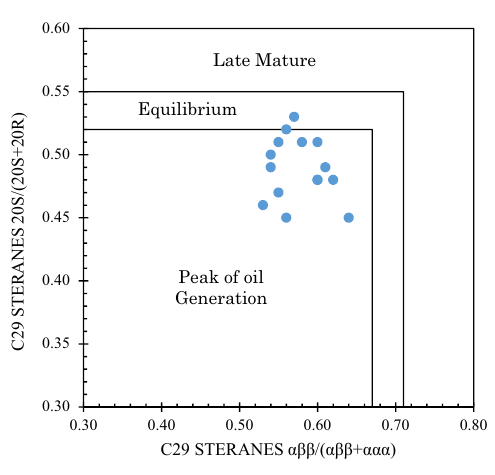
Fig. 4 C 29 sterane isomerization ratios for oil samples from the South Dezful Embayment. The samples fall close to the equilibrium area (marked by solid lines) (after Peters